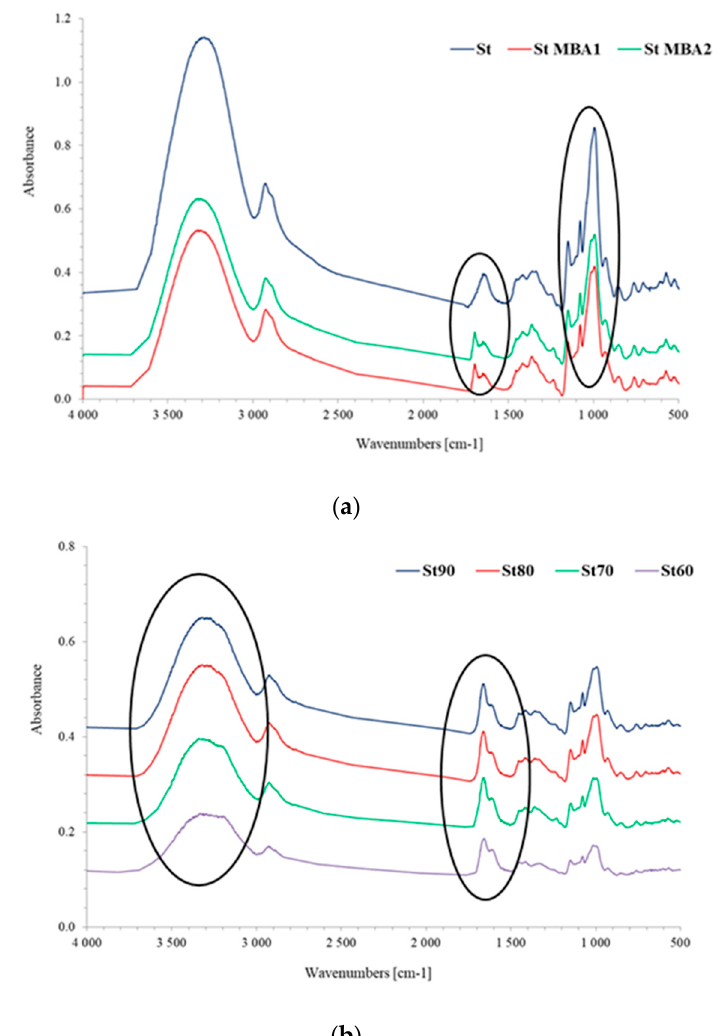
Figure 2. FTIR spectra: ( a ) native potato starch (St) and cross-linked starches (StMBA1 and StMBA2); ( b ) cross-linked starch-g-polyacrylamide absorbents with different amount of natural polymer St90—90 wt.%, St80—80 wt.%, St70—70 wt.% and St60—60 wt.% of starch.